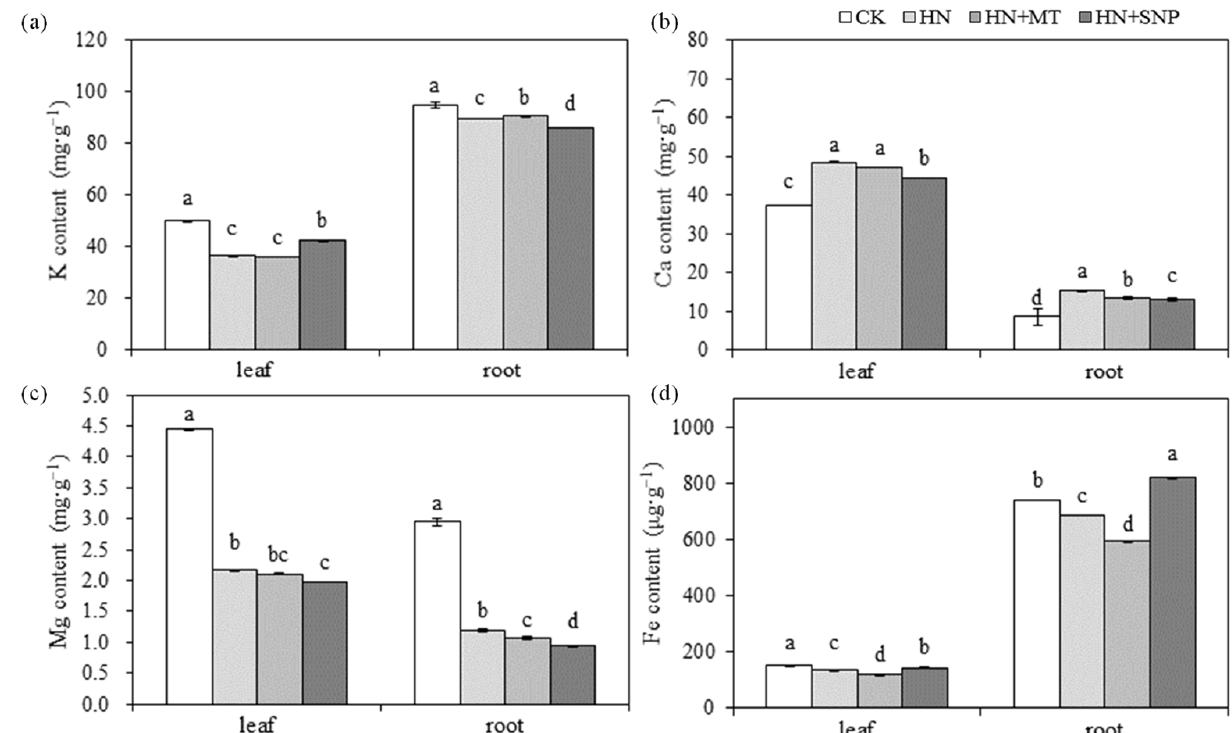
Figure 2. Effects of MT and NO on mineral elements content of cucumber seedlings under nitrate stress. ( a ) Potassium (K). ( b ) Calcium (Ca). ( c ) Magnesium (Mg). ( d ) Iron (Fe). Error bars represent standard deviations of the means of three independent replicates. Different letters indicate signifi- cant differences between treatments by Duncan’s multiple range test ( p < 0.05).